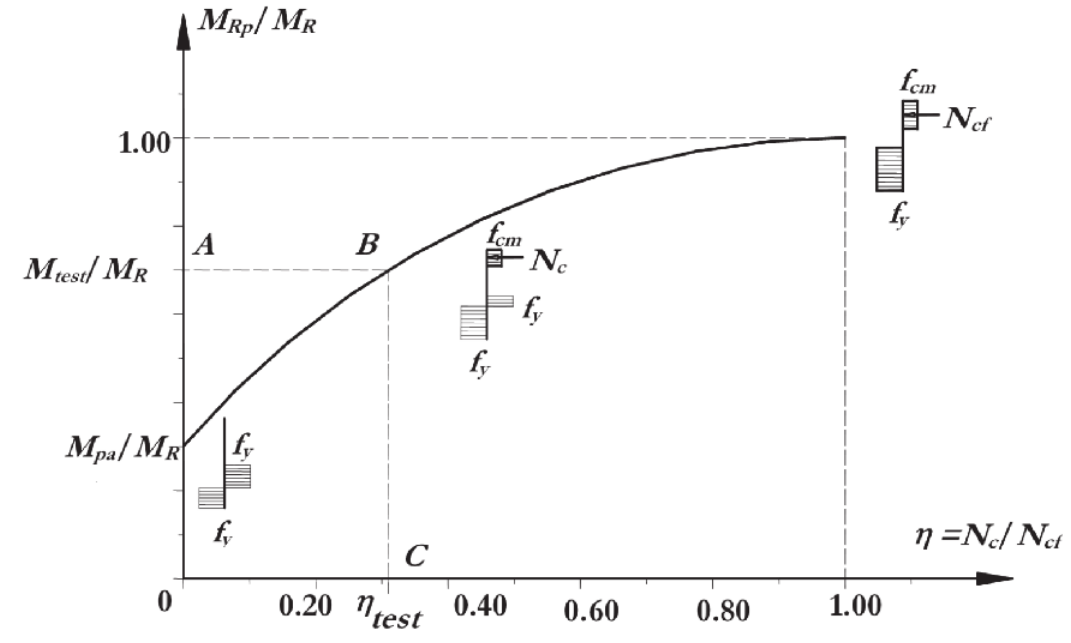
Determination of the degree of shear connection from M